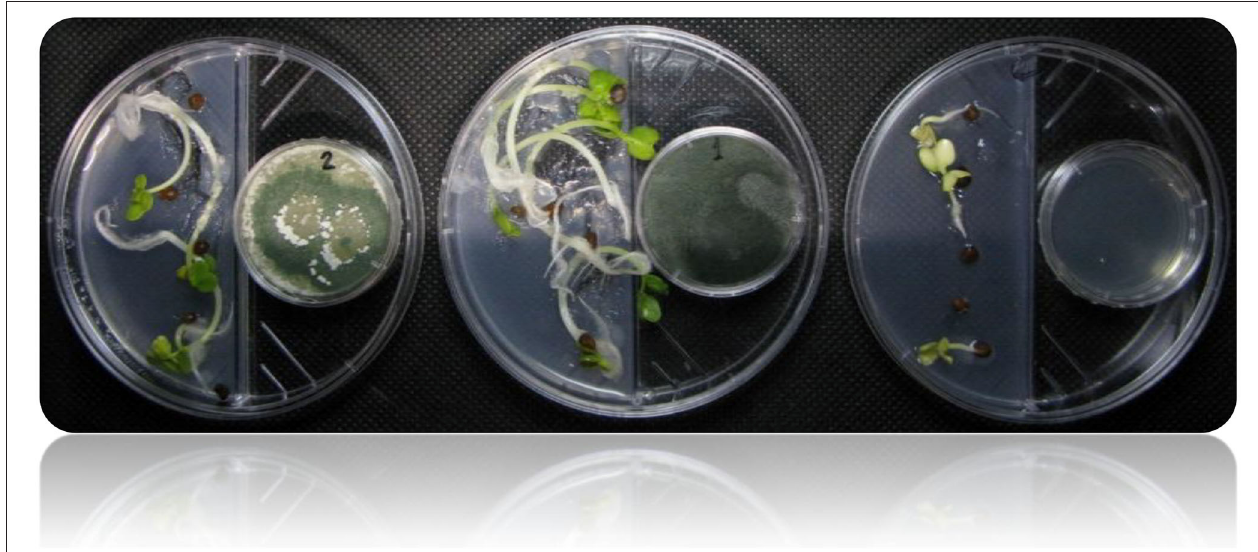
FIGURE 4 | Shows the I-plate system used for assessing plant growth promotion in response to plant growth-promoting Trichoderma -volatiles exposure. This setup allows only volatile compounds to be exchanged, while preventing any diffusion of non-volatile metabolites through the